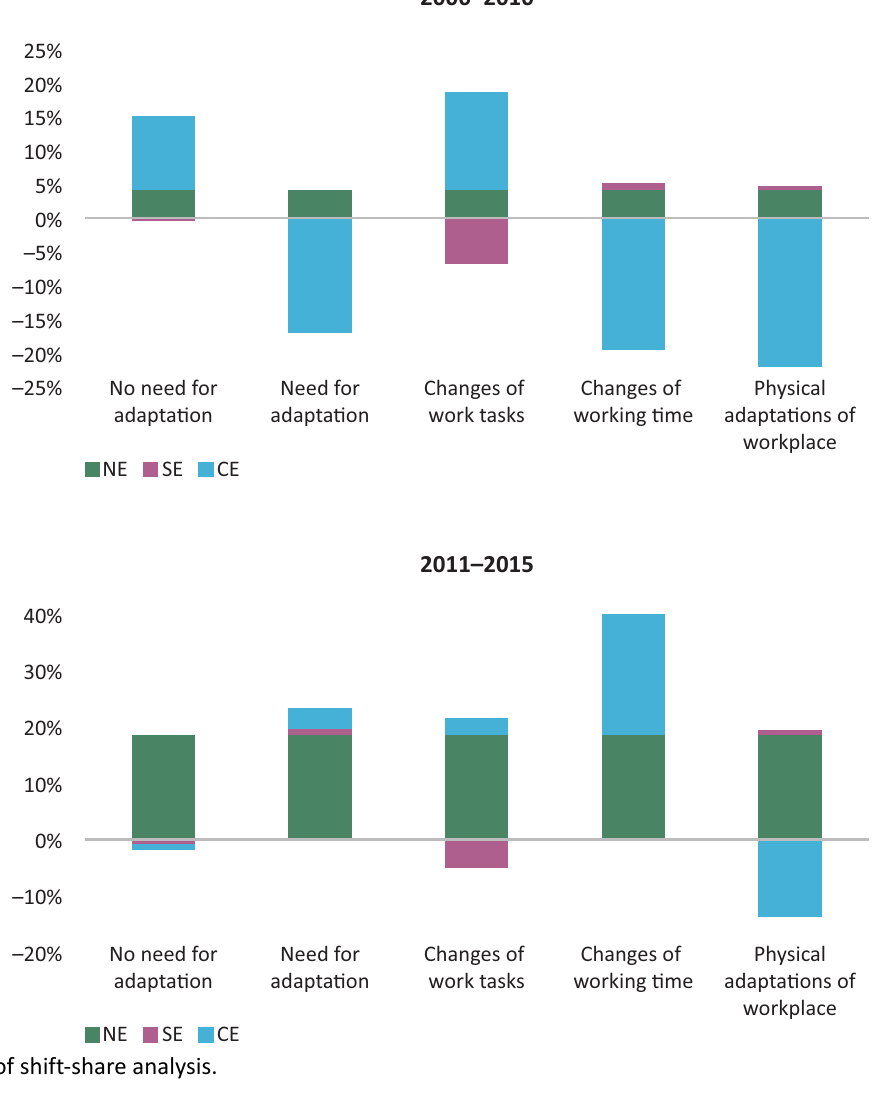
Figure 1. Graph of shift-share